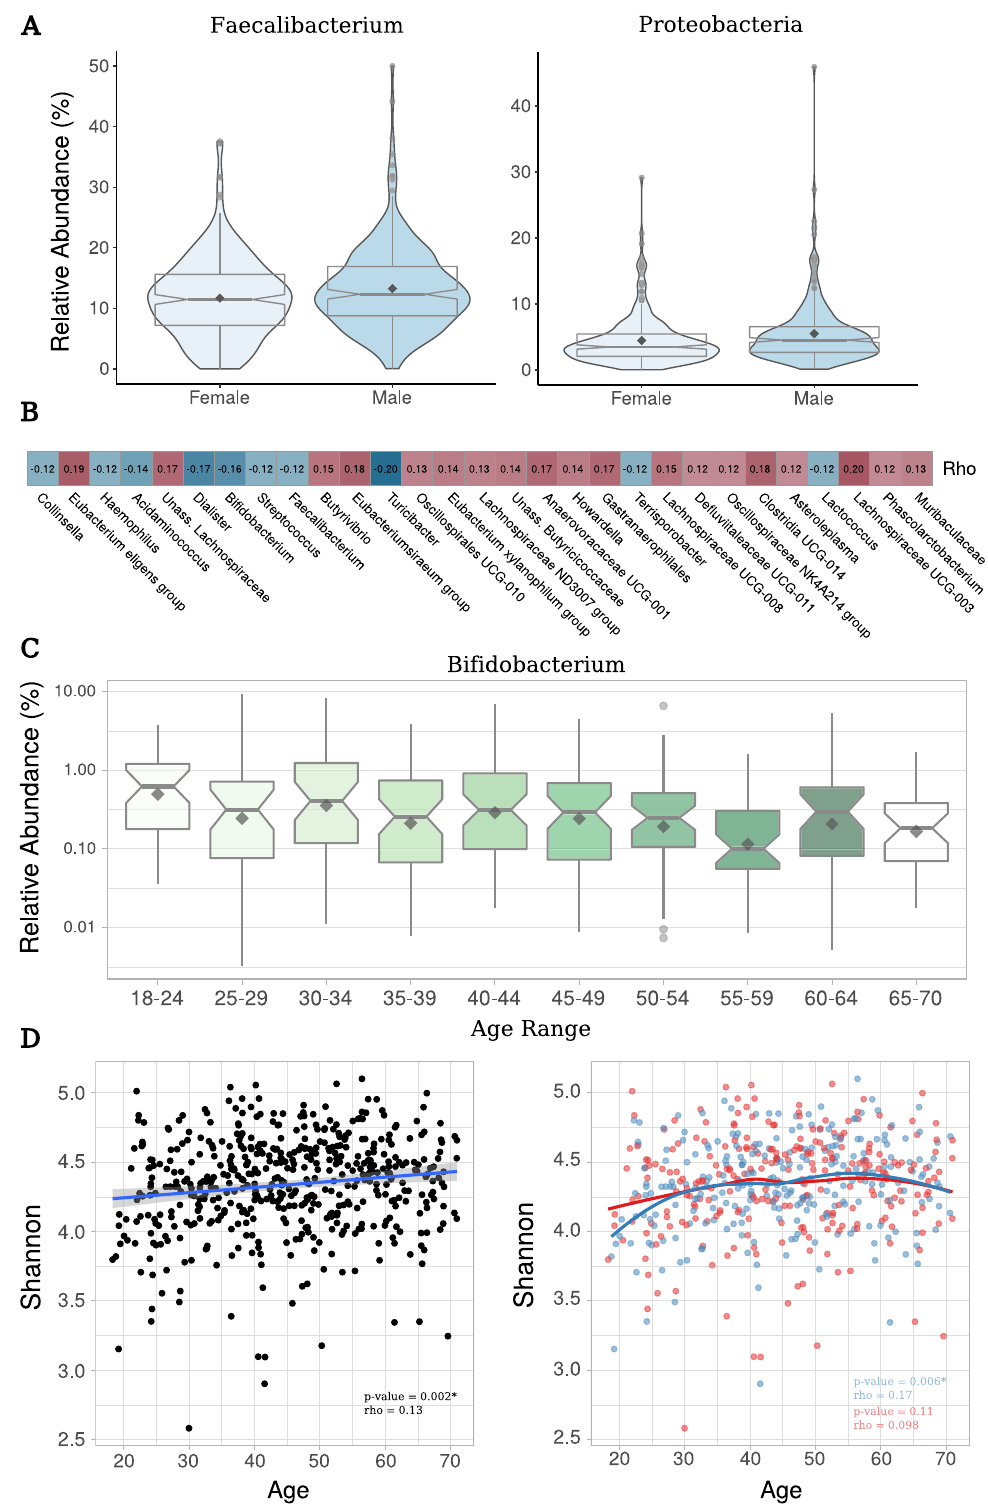
Figure 2. Associations of particular markers with sex and age. ( A ) Relative abundance of Faecalibacterium and Proteobacteria in male and female individuals. ( B ) Genera showing a significant Spearman’s rank correlation (FDR-adjusted p -value < 0.05) with age. Rho = Spearman’s rank correlation coefficient. ( C ) Relative abundance of Bifidobacterium in different age groups. ( D ) Shannon index vs. age considering the whole cohort (left) (linear model “lm” used as smoothing method) or separating by sex (right) (local polynomial regression fitting model “loess” used as smoothing method). Rho and p -values resulting from Spearman’s rank correlation are shown. Black = both females and males; Red = females; Blue =